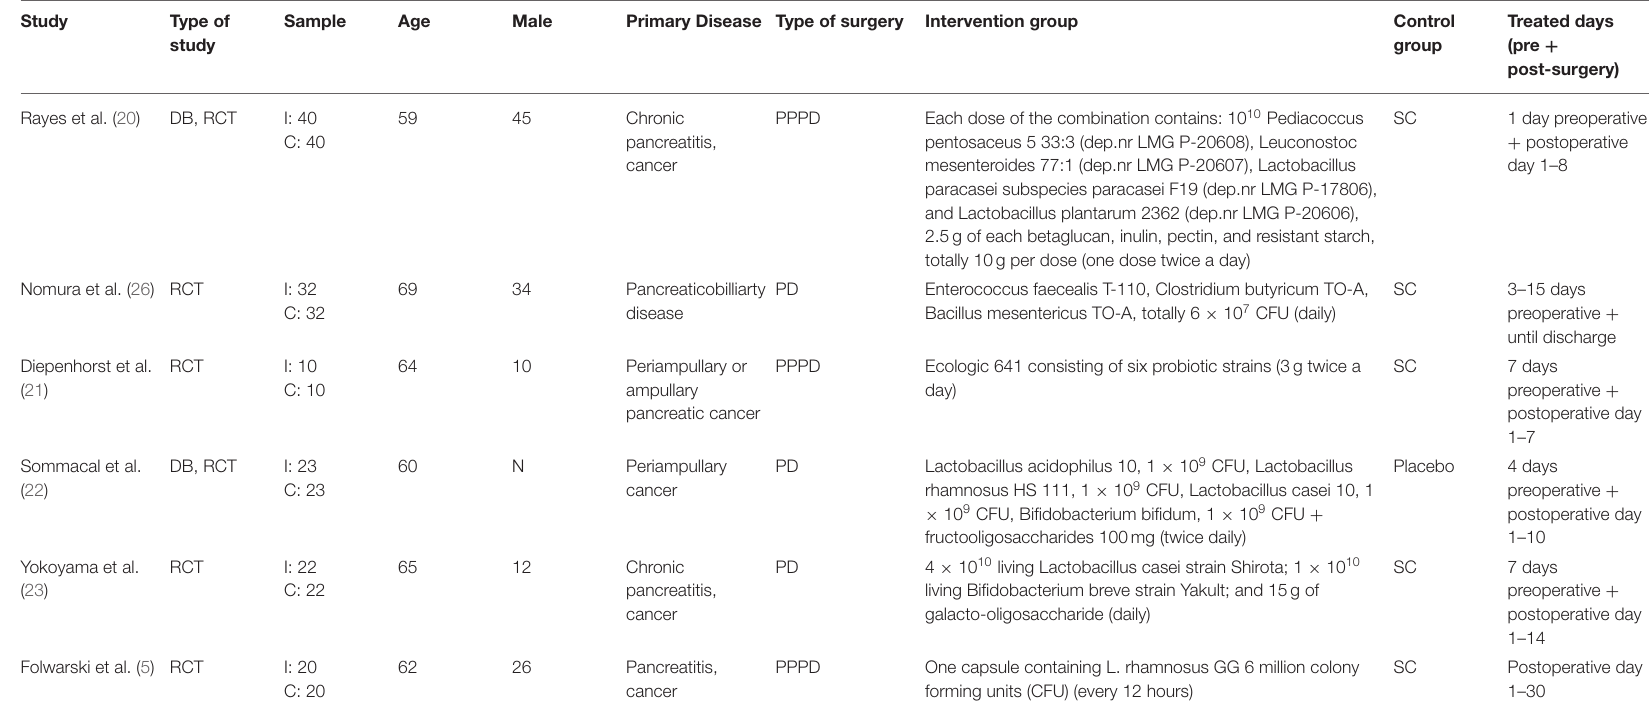
TABLE 2 | Characteristics of six eligible